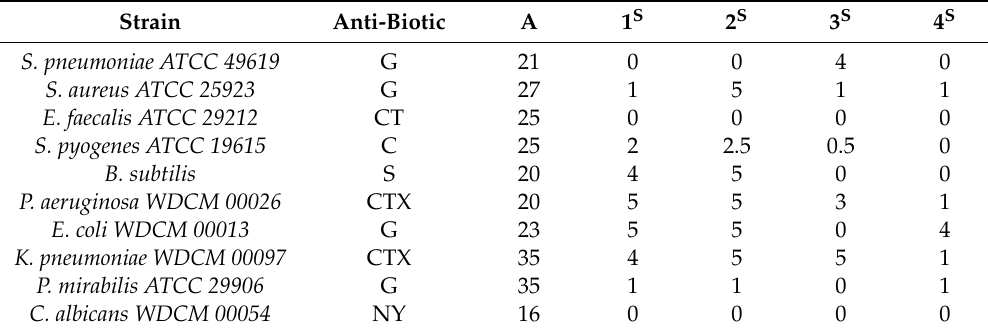
Table 3. Antimicrobial activity of selected antibiotics (A), TCA-AgNP (1), TCA-AgNP-PI (2), Cinn- AgNP (3), Cinn-AgNP-PI (4) and their dip-coated sutures (S). ZOI [mm] against microbial strains by diffusion assay (S). Strain